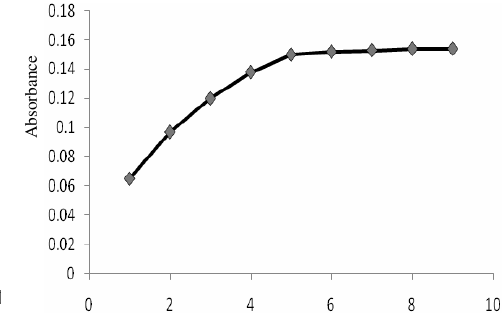
Figure 4. Job’s method of continues variation plot for ion-pair complex of pioglitazone-BCG in chloroform at 419 nm.